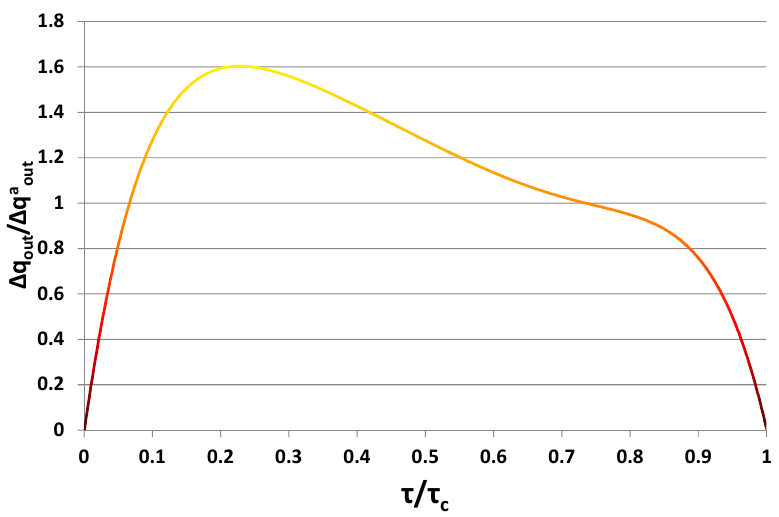
Figure 6. The average theoretical characteristics of changes in heat flux transmitted to the coking chamber wall.